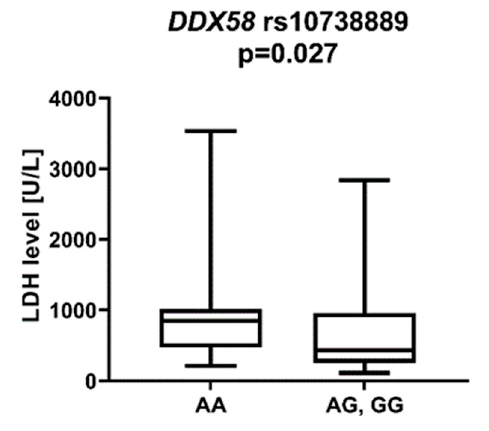
Figure 8. LDH level in patients with DDX58 rs10738889 G allele.